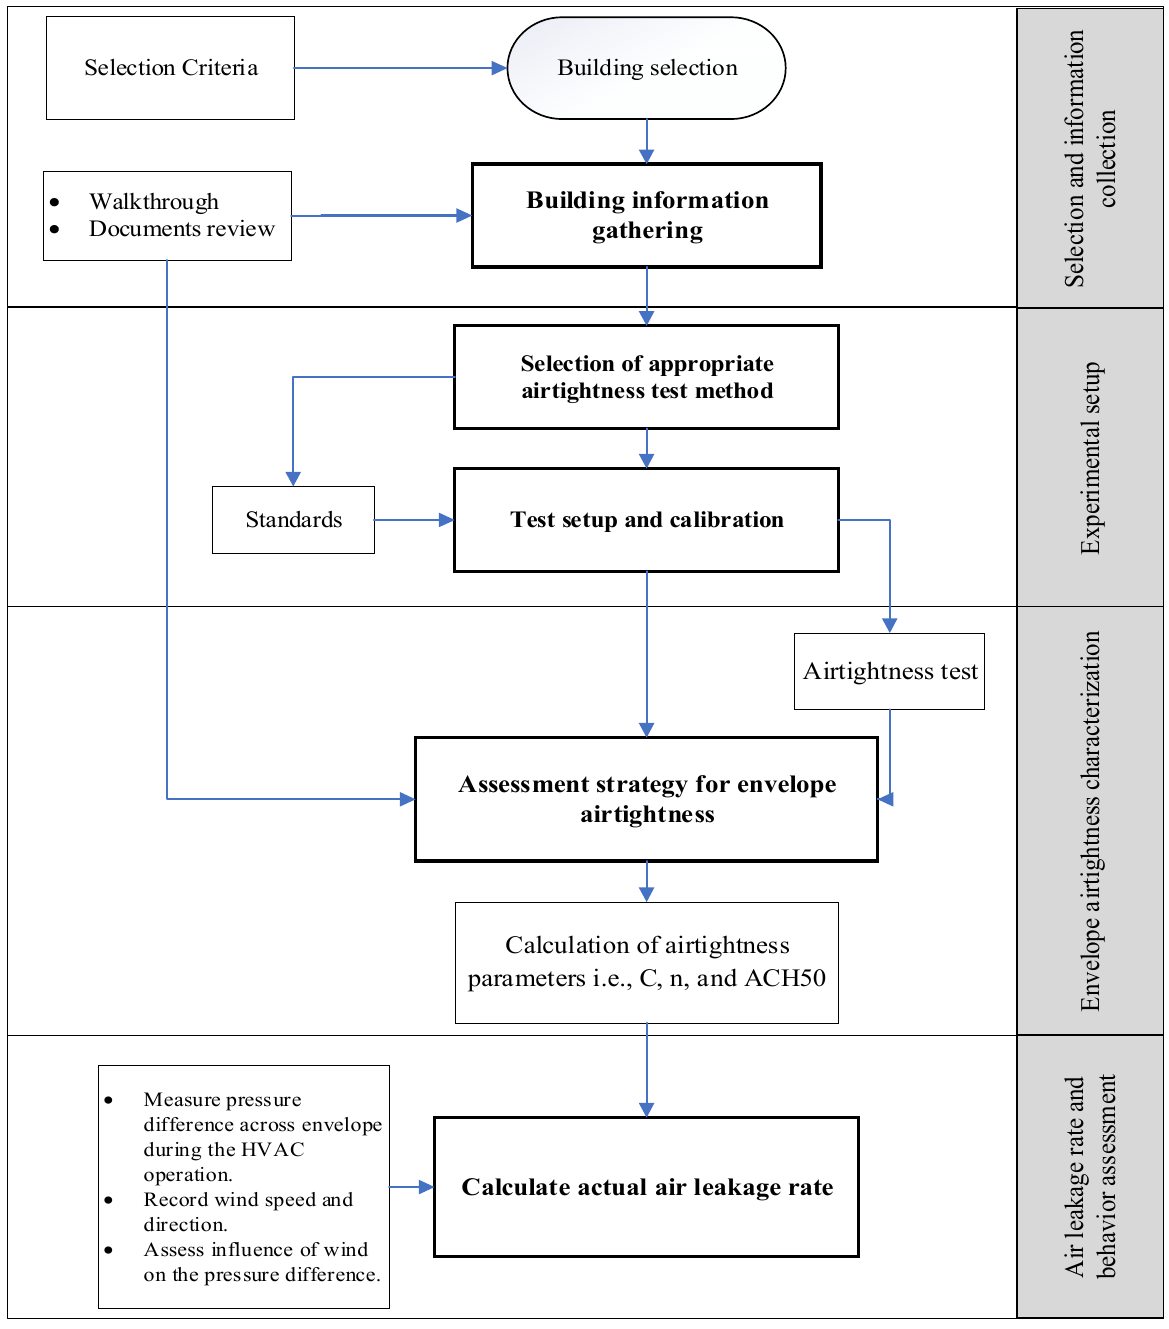
Figure 2. The approach for characterization of air leakage